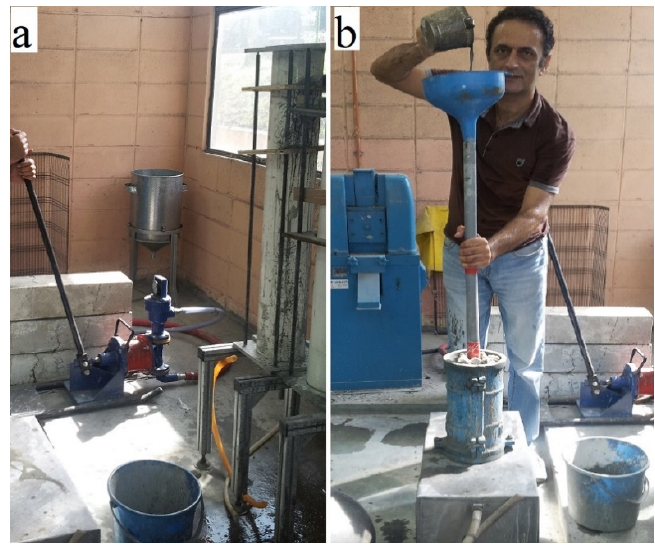
Figure 2. Methods of pre-packed aggregate concrete (PAC) grouting: ( a ) pumping; ( b ) gravity.